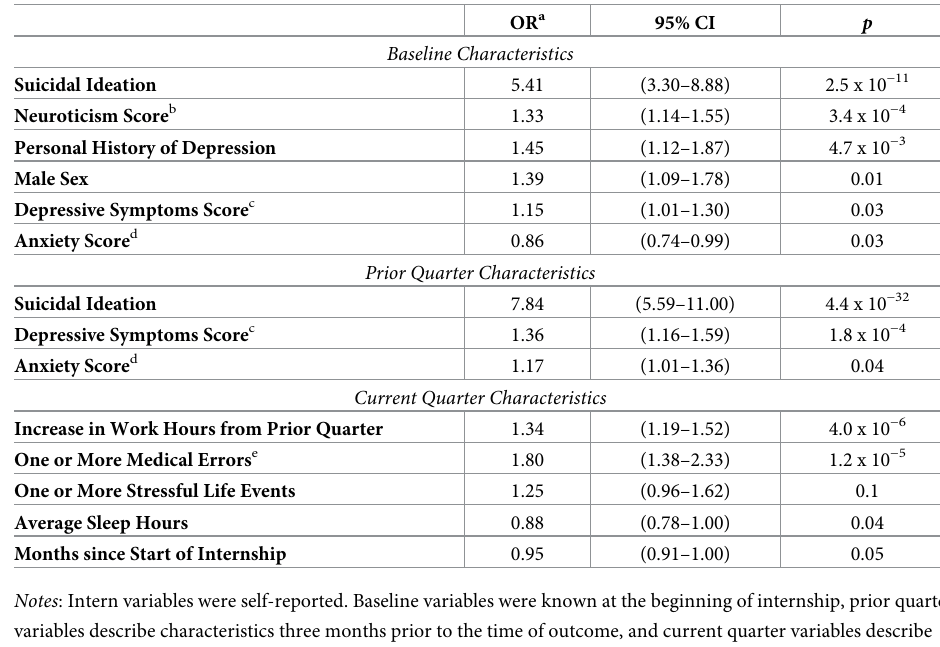
Table 2. Logistic mixed effects multiple regression analysis predicting current quarter suicidal ideation from intern mental health, demographics, and internship